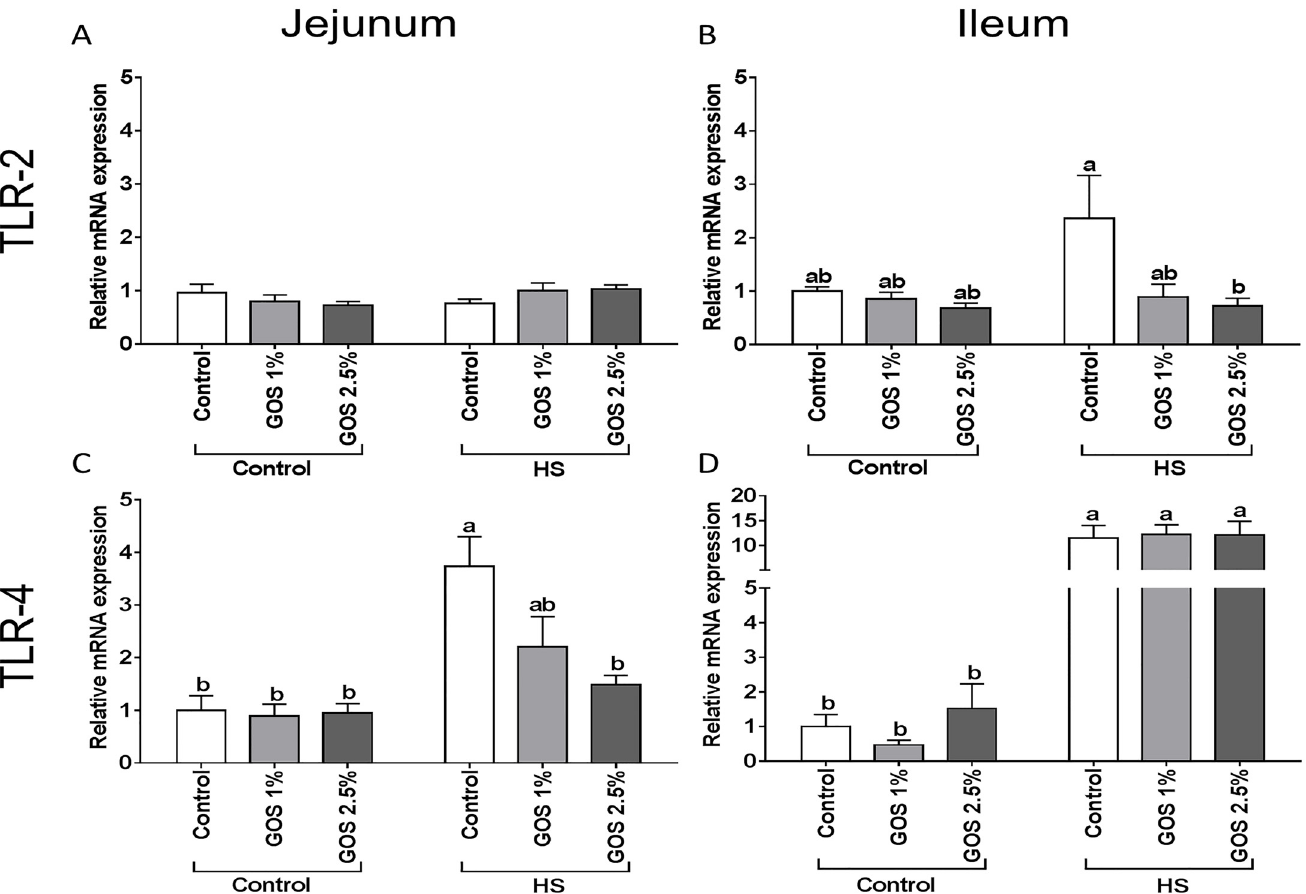
Fig 4. The effect of heat stress exposure on the mRNA expression of TLR-2 and TLR-4 in jejunum and ileum of chickens fed a control or GOS diet. Chickens fed a control or GOS (1 or 2.5%) diet for 6 days before being exposed to either control or heat stress conditions for 5 days. mRNA expression of TLR-2 (A, B) and TLR-4 (C, D) in jejunum (A, C) and ileum (B, D) were evaluated by qRT-PCR. Results are presented as relative mRNA expression (fold of control, normalized to β -actin) as mean ± SEM, n = 6 – 10 animals/experimental group. Different lower-case letters denote significant differences among